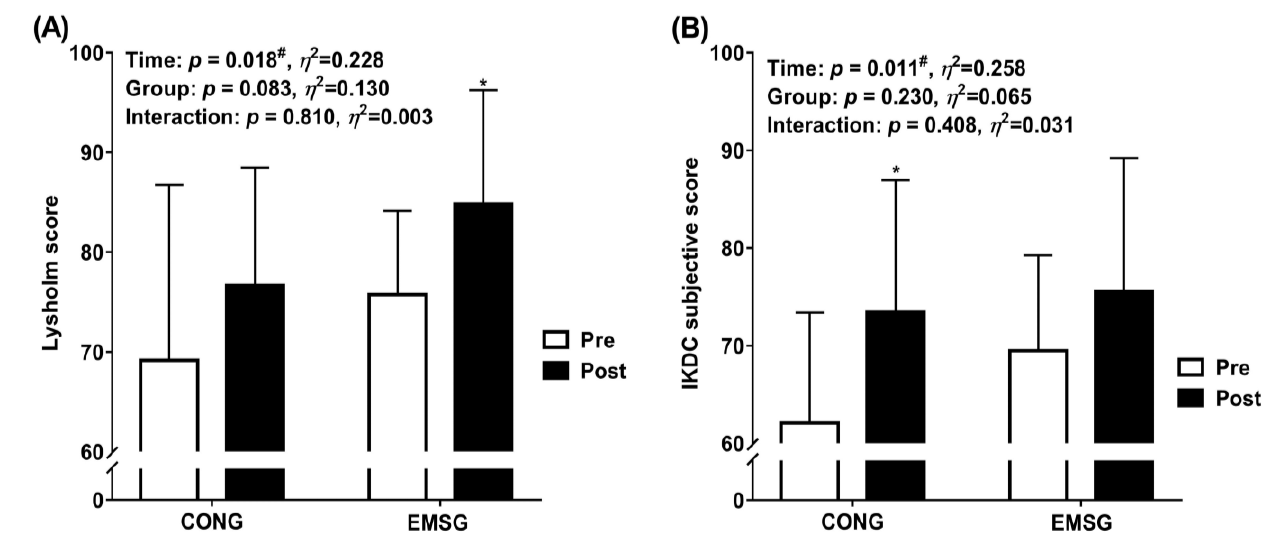
Figure 4. The rehabilitative exercise programs’ effects on Lysholm score and IKDC score. ( A ) Com- pared in Lysholm score. ( B ) Compared in IKDC score. control group; CONG, electro muscle stimu- lation group; EMSG, International Knee Documentation Committee; IKDC. # p < 0.05: main effect or interaction; * p < 0.05: pre- and post-test.